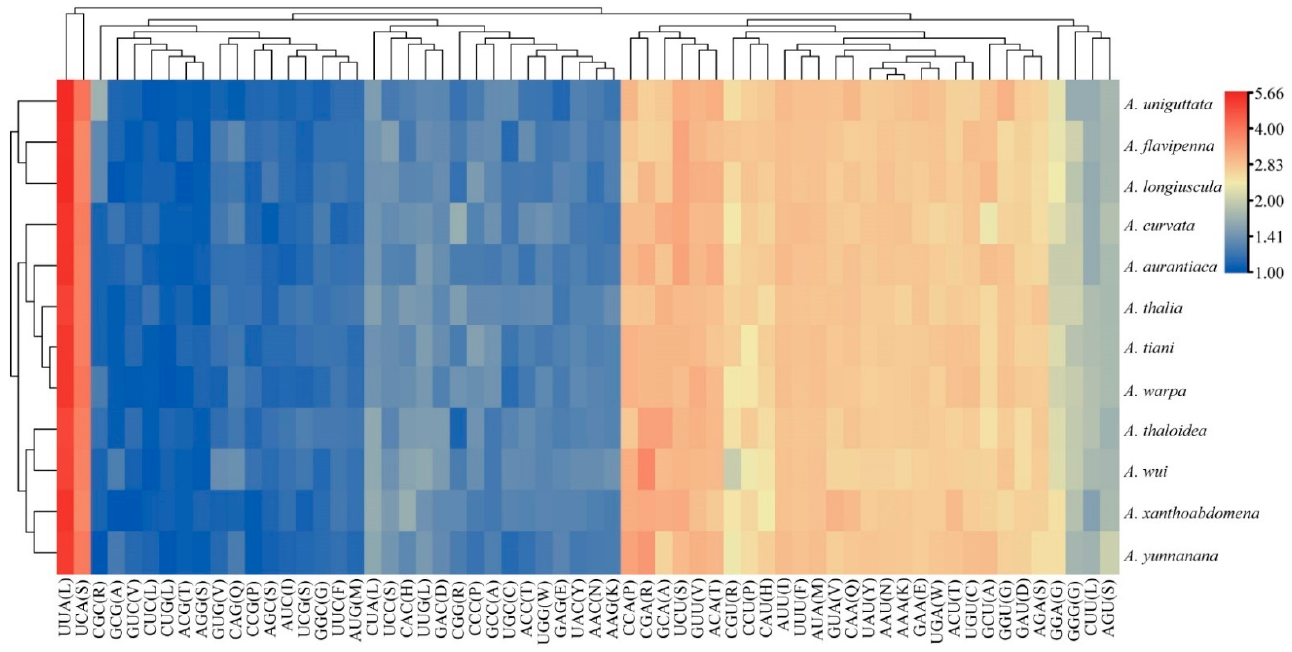
Figure 2. The relative synonymous codon usage (RSCU) of PCGs in the 12 newly sequenced mitogenomes. The x-axis and y-axis indicate the hierarchical clustering of codon frequencies and Atkinsoniella species, respectively.